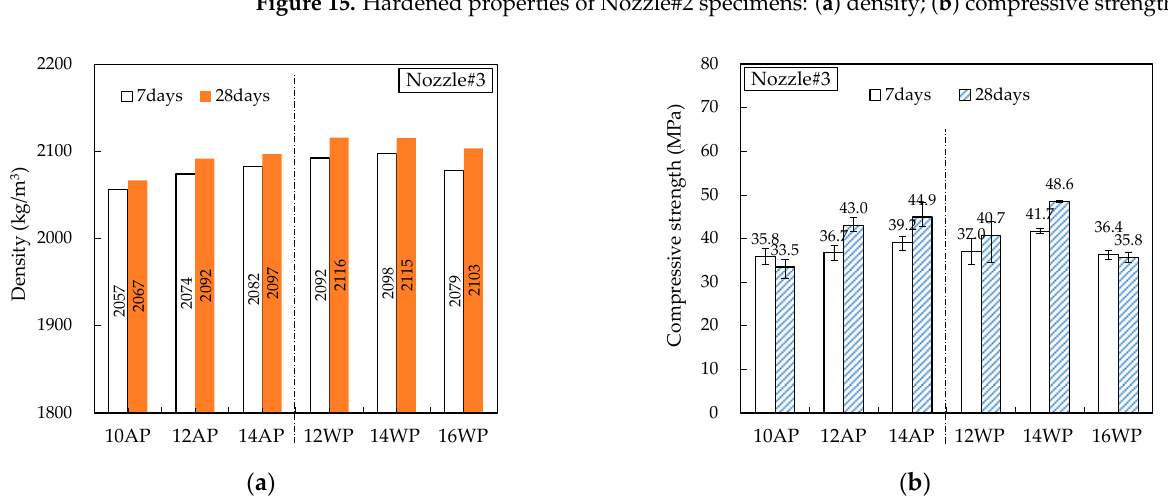
Figure 15. Hardened properties of Nozzle#2 specimens: ( a ) density; ( b ) compressive strength.